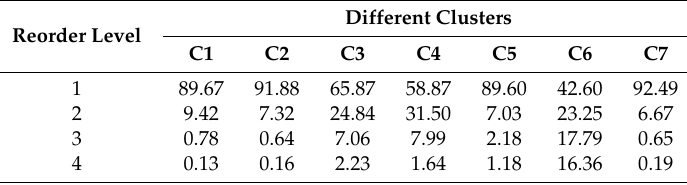
Table 8. Average conditional probability of different reorder levels given different clusters